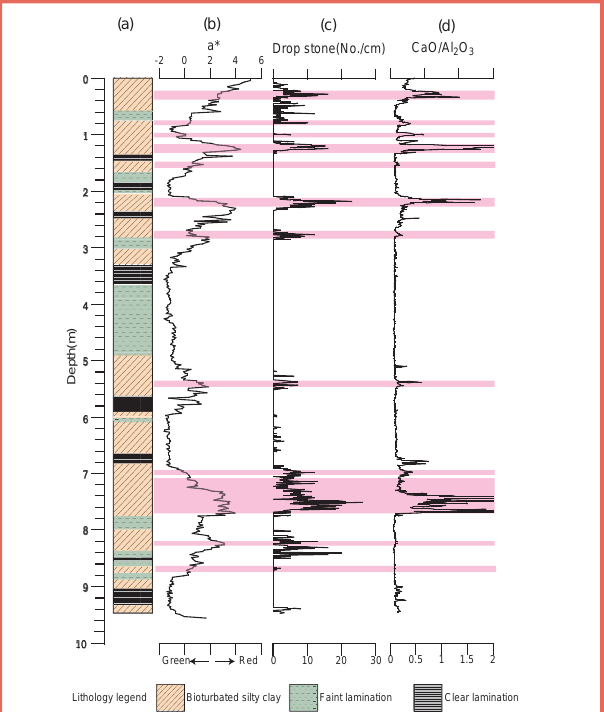
Figure 3. Example for the TATSCAN-F2 measurement for wet soft sediment core, MR99-K03-PC1 from the Chukchi Sea, Arctic Ocean. (a) Graphic representation of geological column. (b) The color index of a* of color re fl ectance. (c) Numbers of dropstone (>2 mm in diameter) counted on soft x-ray image of the core. (d) Elemental ratio of Ca/Al analyzed by the TATSCAN-F2. Color- shaded intervals represent relatively bioturbated reddish-color silty clay layers with a high concentration of dropstones and a high Ca/Al ratio, corresponding to the interglacial seasonal change in sea-ice conditions.